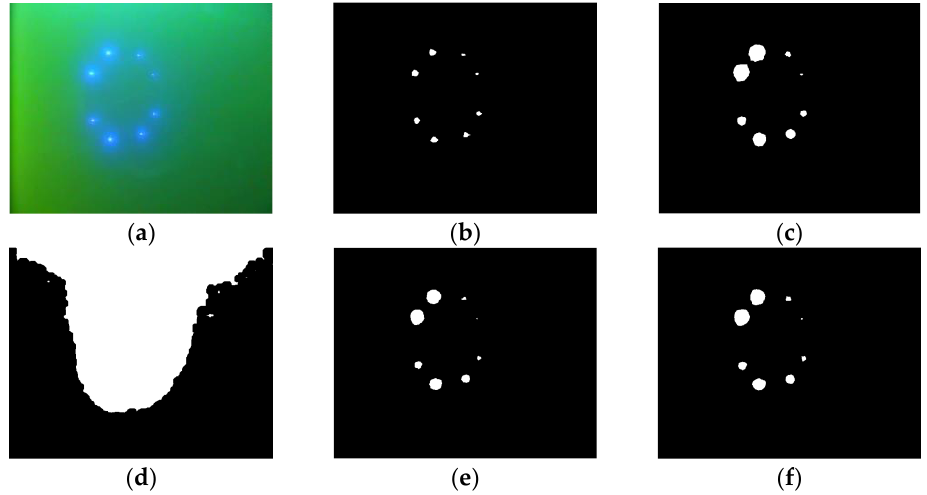
Figure 23. The guidance feature extraction results of five methods for an example guidance image: ( a ) original image; ( b ) extracted guidance features from the method proposed in this study; ( c ) extracted guidance features from fixed thresholding; ( d ) extracted guidance features from Otsu thresholding; ( e ) extracted guidance features from HATS; and ( f ) extracted guidance features from HSTS. Table 4. Comparison of results for guidance feature extraction using five different methods.